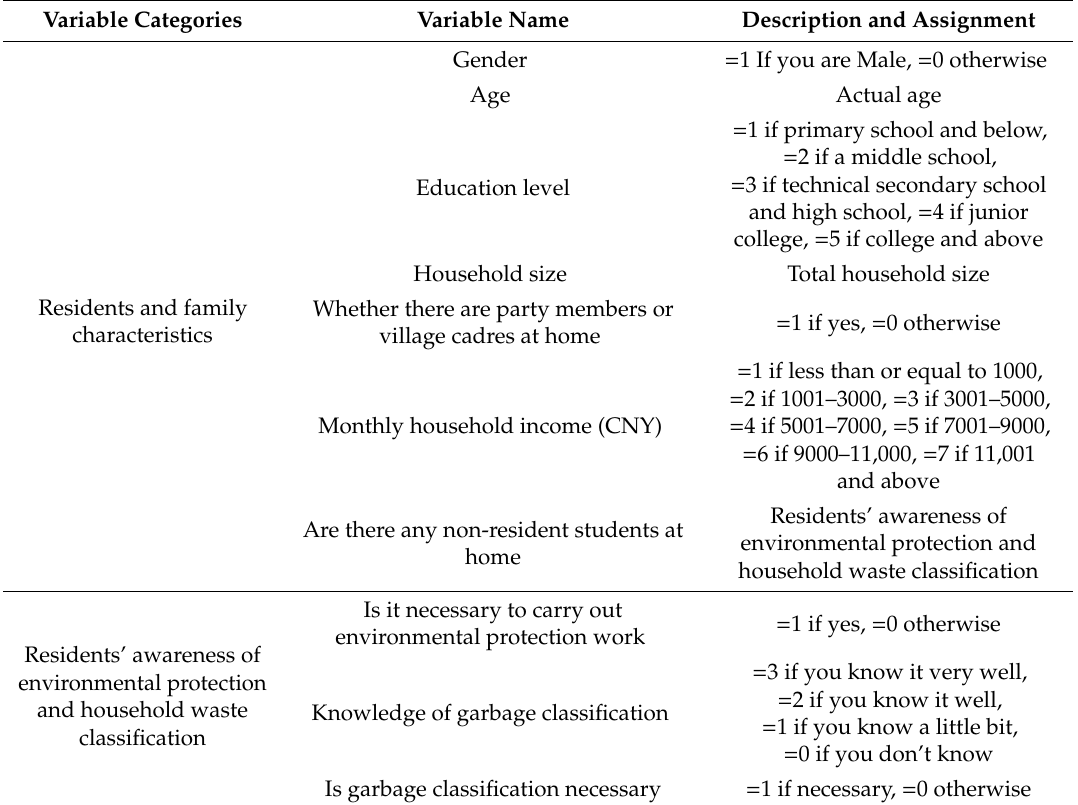
Table 2. Variable